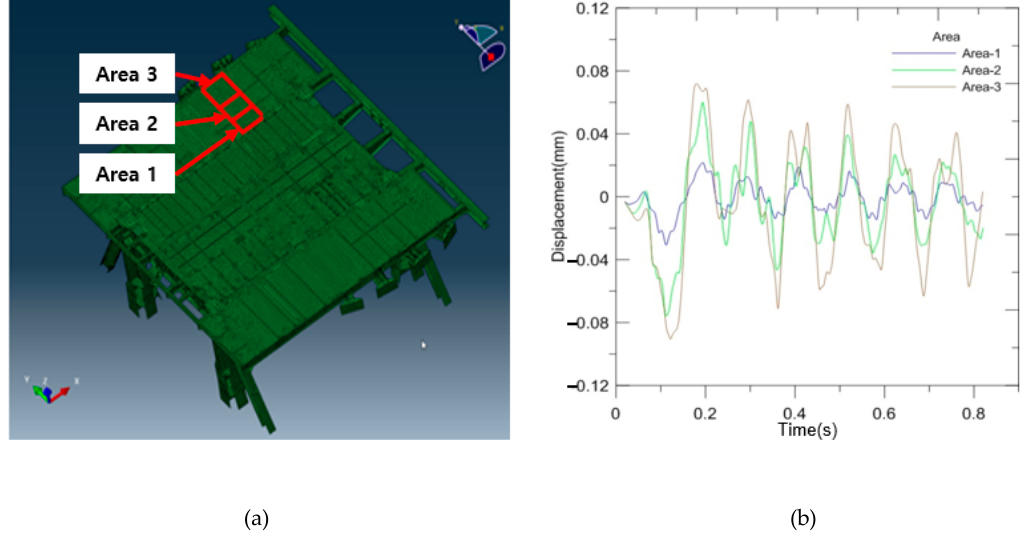
Figure 18. ( a ) Location of displacement measurement and ( b ) measured displacement of plate S235 for each area in case-1.